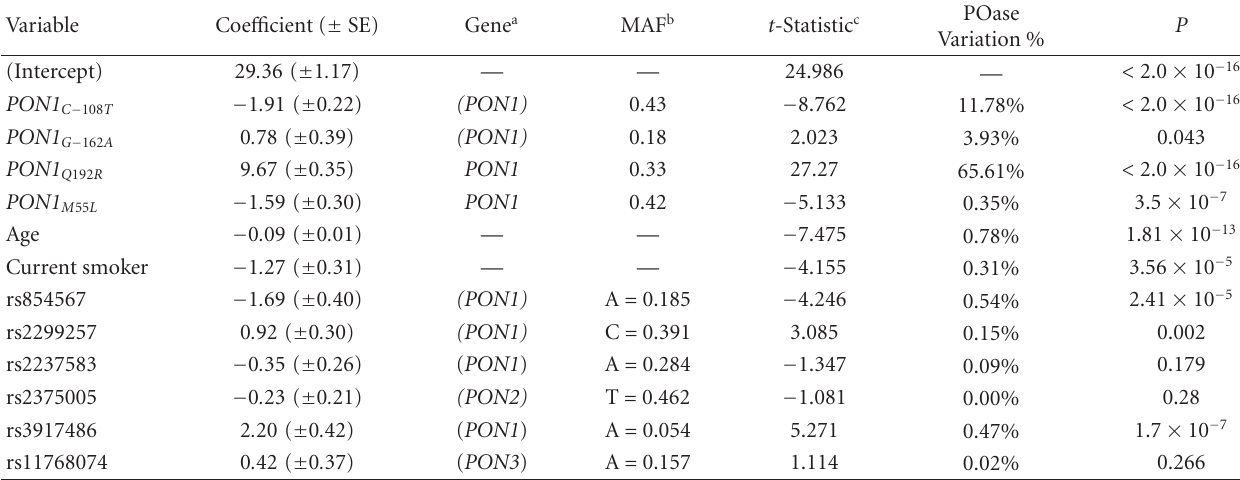
Table 3: Application of best-fit model for PON1 AREase activity to predict PON1 POase